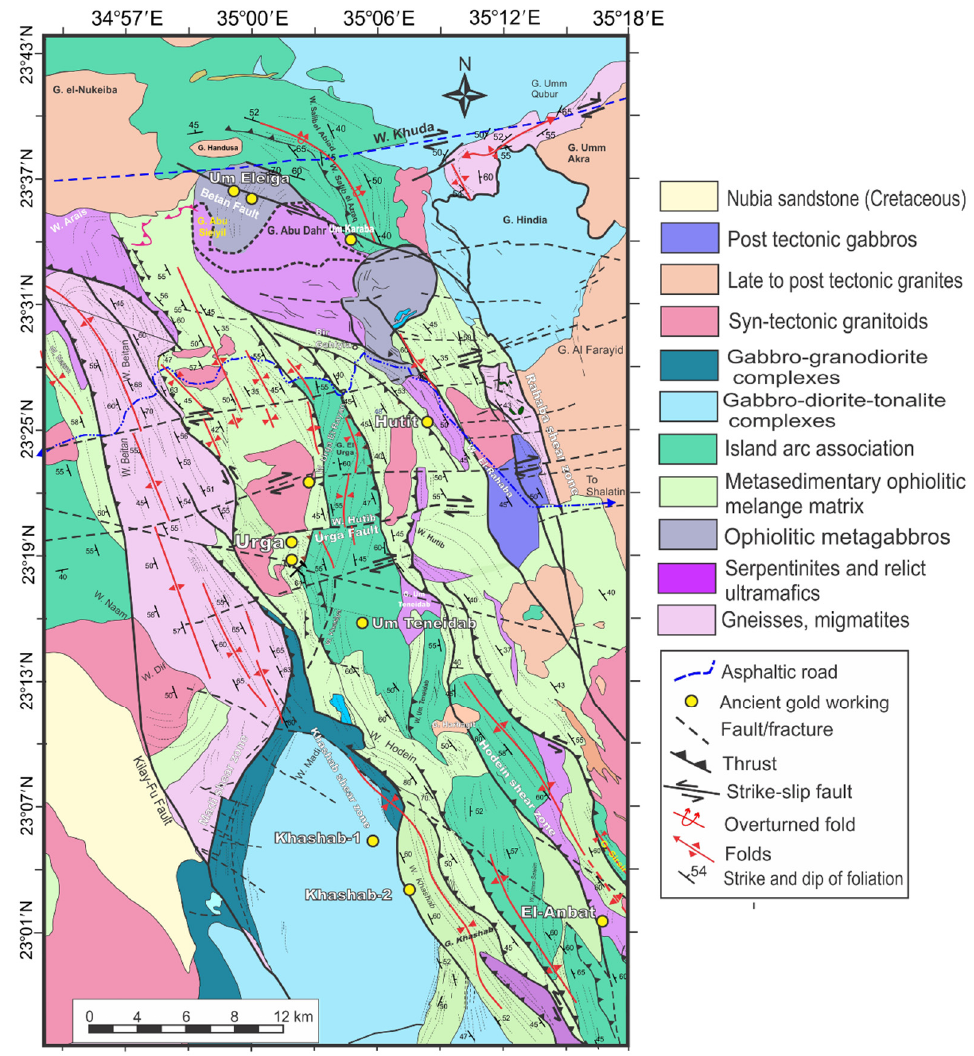
Figure 2. Geological map of Wadi Hodein–Beitan shear belt (complied and modified from [36–39]). The Wadi Khashab–Gabal Sirsir ophiolites form two discontinuous NNW–SSE ori- ented belts of mainly serpentinite, metabasalt, ophiolitic and metagabbro rocks [12,36,38,39]. Serpentinite and associated talc carbonate occur as masses elongated in a NW–SE direction (e.g., Gabal Sirsir and Wadi El-Beida) and tectonically emplaced within the foliated metavolcanics and volcaniclastic metasediments. Serpentinites and foliated metabasalts in the Gabal Sirsir–El-Anbat belt occur as elongate lenses along NW to NNW–SSE shear zones [37–40]. The mafic metavolcanics form NW-elongated belts bound by highly sheared rocks and mylonites. The metavolcanics rocks are intruded by metagabbro–diorite, gran- odiorite and granitoid intrusions. They are strongly foliated and exhibit well developed pencil cleavage and boudinage patterns. They comprise metaandesite/basaltic andesite and tuffaceous intercalations. The metasedimentary rocks include metagreywacke, bedded metamudstone, metaconglomerate and schists with minor calcareous beds. The Gabal Abu Dahr ophiolitic m é lange in the central and eastern parts of the study area occur as